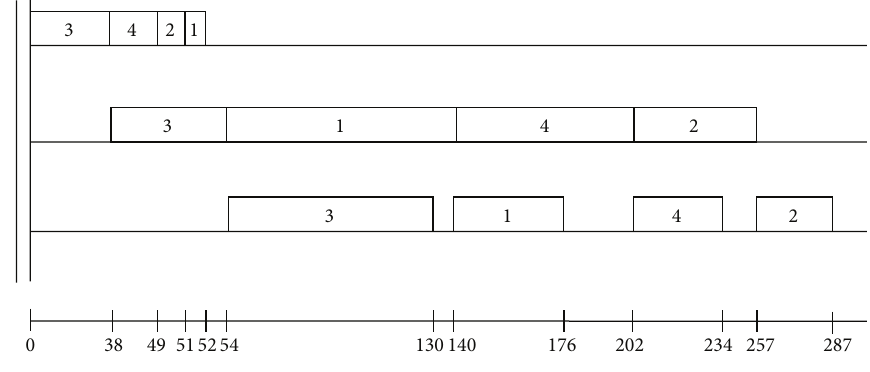
Figure 9: Schedule of Example 4 according to LPT rule.